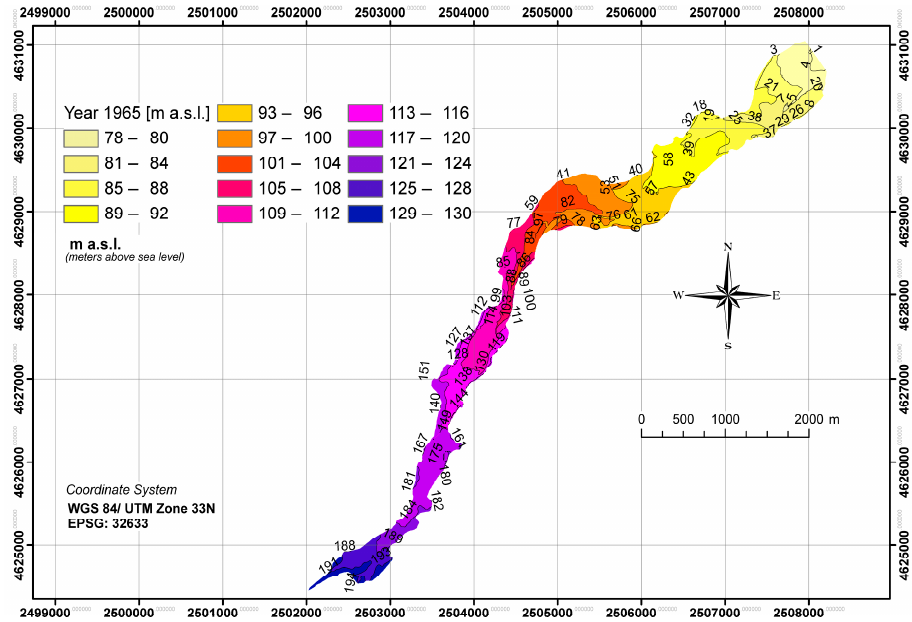
Figure 6. Contour lines in the fluvial reach immediately upstream of the Di Blasi bridge (1965).